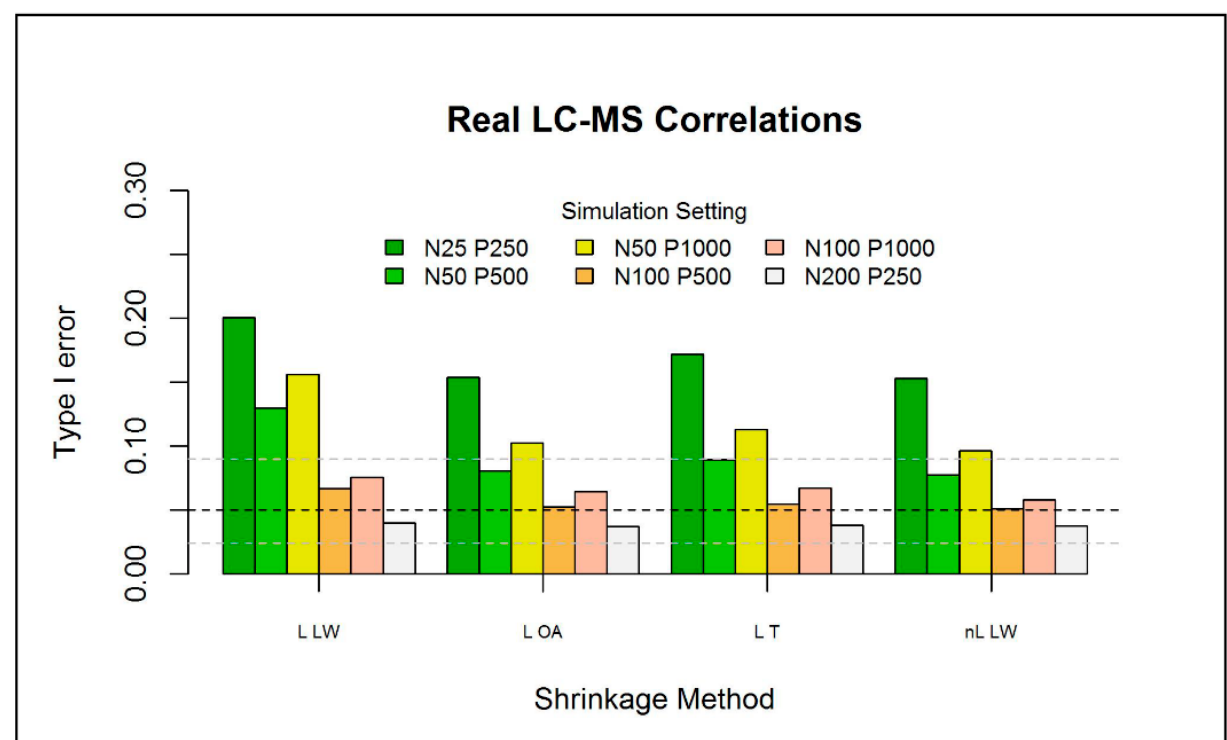
Figure 4. Type I error (over 200 simulations) for the eigenvalue-shrinkage approaches for the MD (with χ 2 —based critical limits) for a P-variate normal distribution with 0 mean and type (iii) covariance matrix. The horizontal black dashed line indicates the expected type I error (0.05) with the respective binomial Clopper–Pearson interval (horizontal grey-dashed line), with parameters 0.05 ∗ 200 and 200. The test data has the same multivariate normal structure of the train data, with a fixed sample size of N = 100, where P equals the size of the train data.